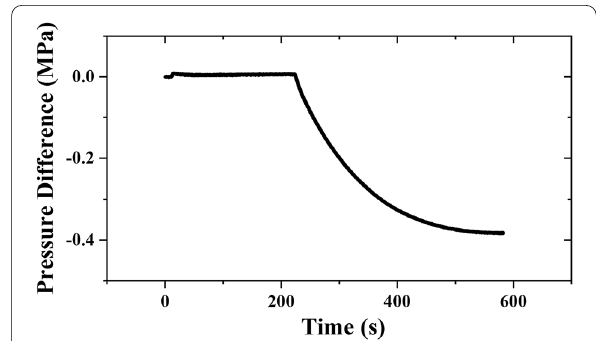
Figure 9 Variation of pressure difference with time